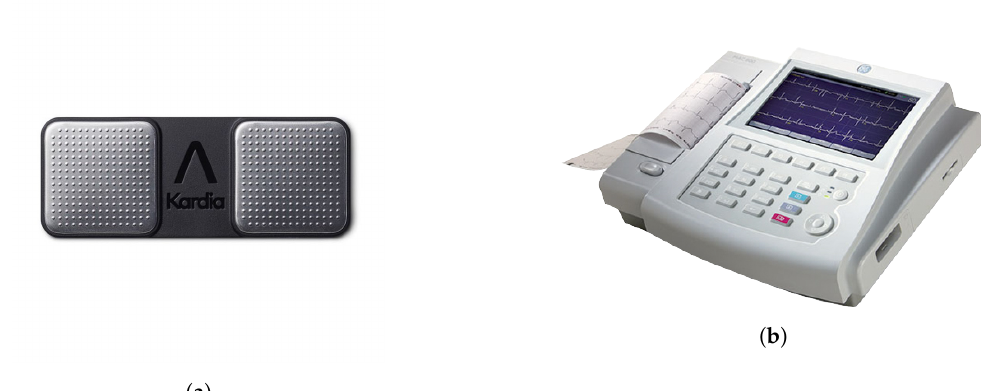
Figure 7. Kardia Mobile device by AliveCorc ( a ) and MAC800 by General Electric Healthcare ( b ); both employed for the calibration